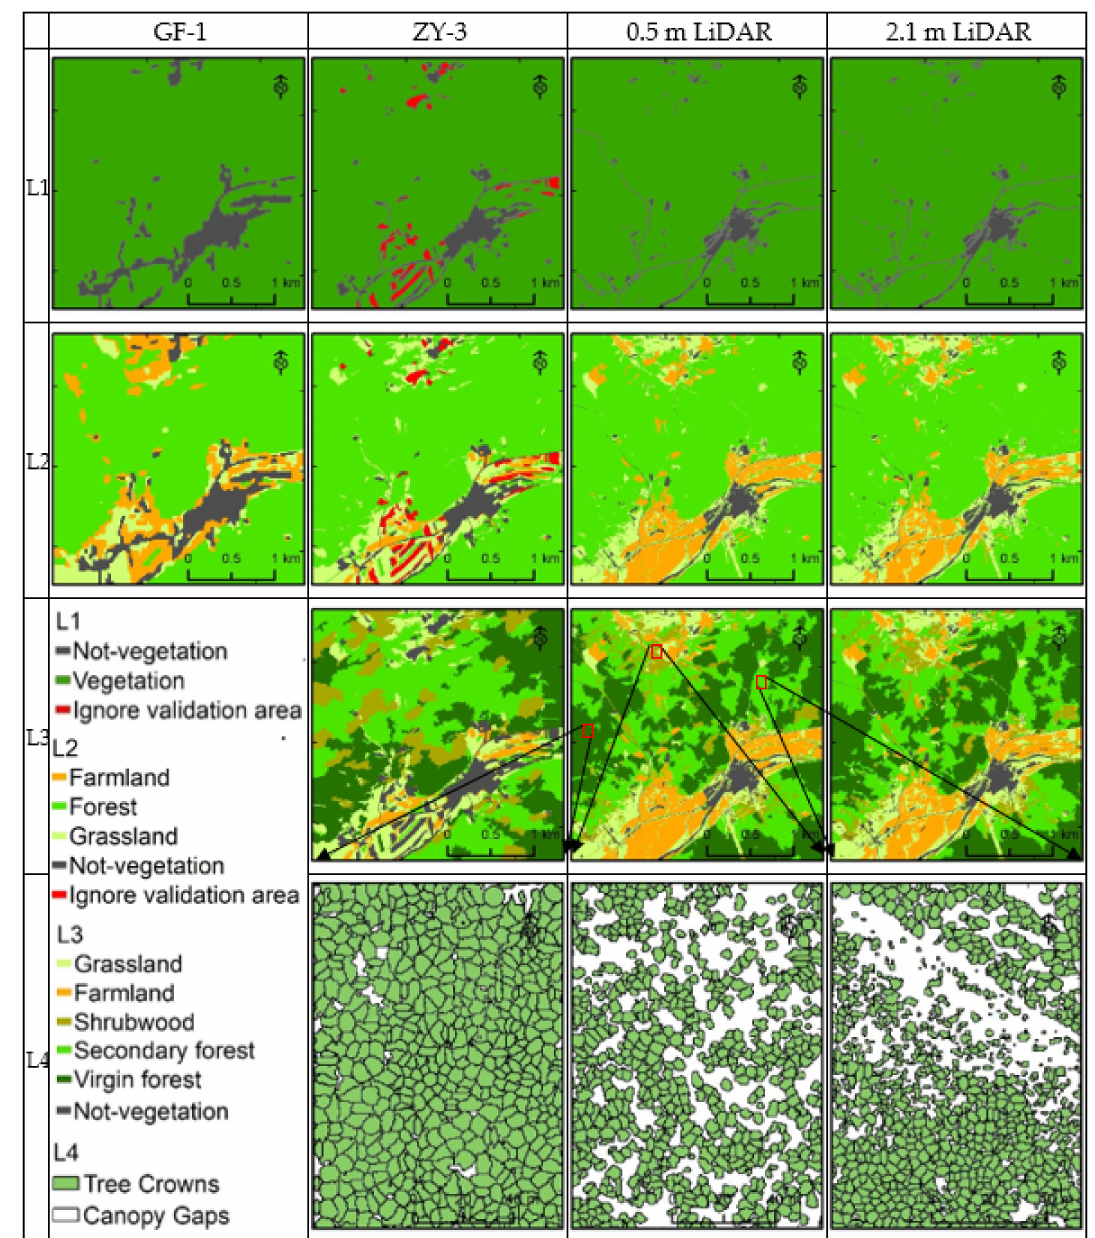
Figure 4. Distribution of L1 (vegetation and non-vegetation), L2 (vegetation type), L3 (forest type) and L4 (canopy and canopy